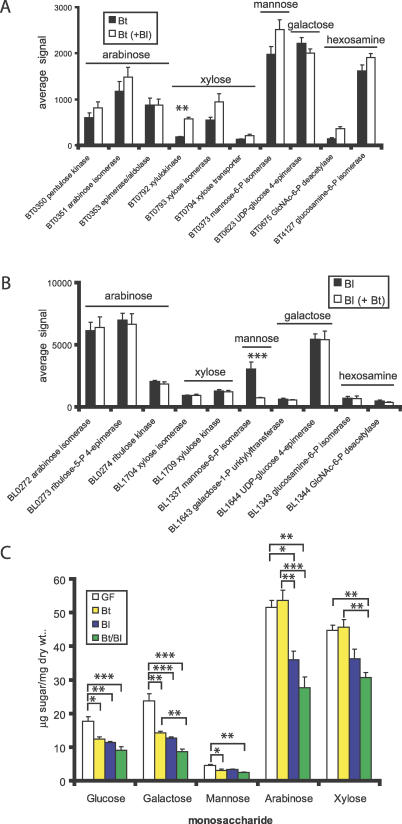
Carbohydrate Utilization by B. thetaiotaomicron and B. longum in the Presence or Absence of One Another(A) and (B) Average expression levels for five cecal samples are shown for genes encoding enzymes that shunt the indicated monosaccharides into the glycolytic or pentose phosphate pathways. Values obtained from mono-associated mice are shown with black bars, and from co-colonized mice with white bars. Significant differences in expression levels were determined using Student t-test; double asterisks (**) indicate p < 0.01, and triple asterisks (***) indicate p < 0.001.(C) GC-MS determination of monosaccharide composition in the ceca of germ-free (GF), B. thetaiotaomicron mono-associated (Bt), B. longum mono-associated (Bl), or B. thetaiotaomicron/B. longum co-colonized (Bt/Bl) mice. Mean values ± S.E. of biological triplicates are plotted. Significant changes in the abundance of a monosaccharide were identified using a one-way ANOVA followed by a Tukey post test; a single asterisk (*) indicates p < 0.05, double asterisks (**) indicate p < 0.01, and triple asterisks (***) indicate p < 0.001.